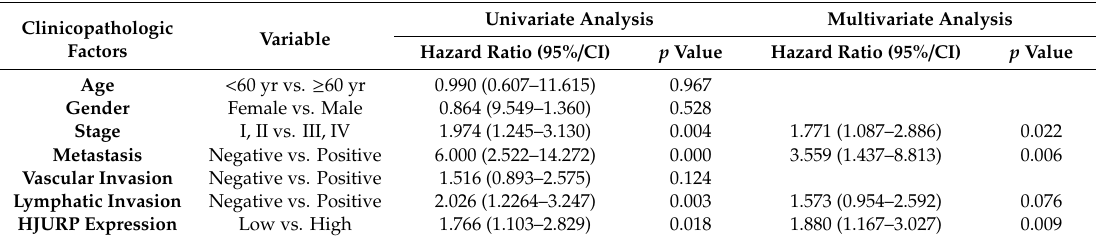
Table 2. Cox regression analysis of the clinicopathological parameters in colorectal cancer patients.